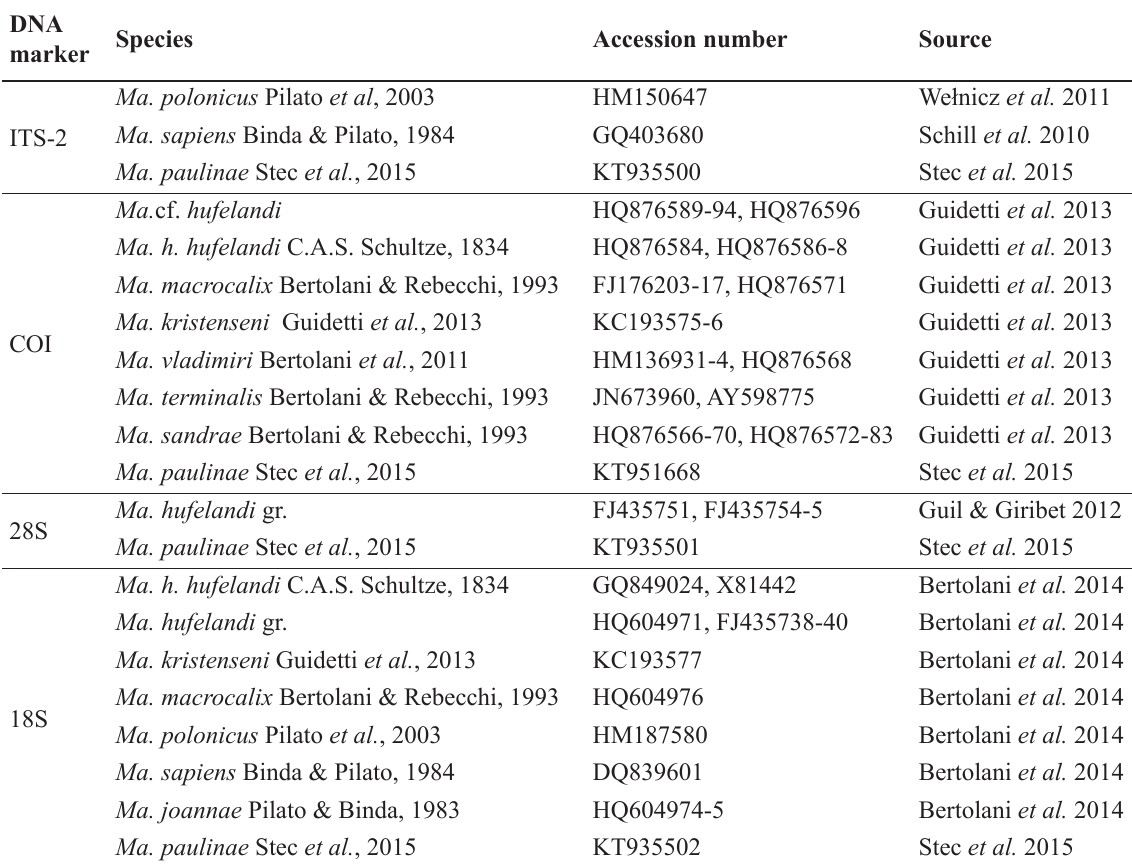
Table 2. Sequences used for molecular comparison of Macrobiotus polypiformis sp. nov. with several other species from the Macrobiotus hufelandi group.